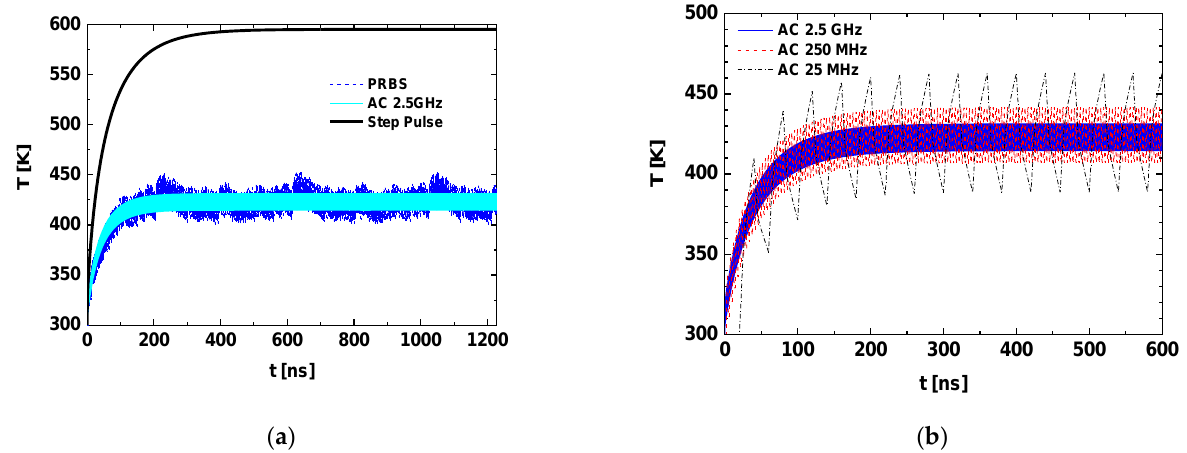
Figure 3. Temperature response in linear time scale to ( a ) different signal voltage stresses of AC signal (cyan), PRBS signal (blue) and step pulse (black); ( b ) AC signals with different frequencies of 2.5 GHz (blue), 250 MHz (red) and 25 MHz (black) [26].